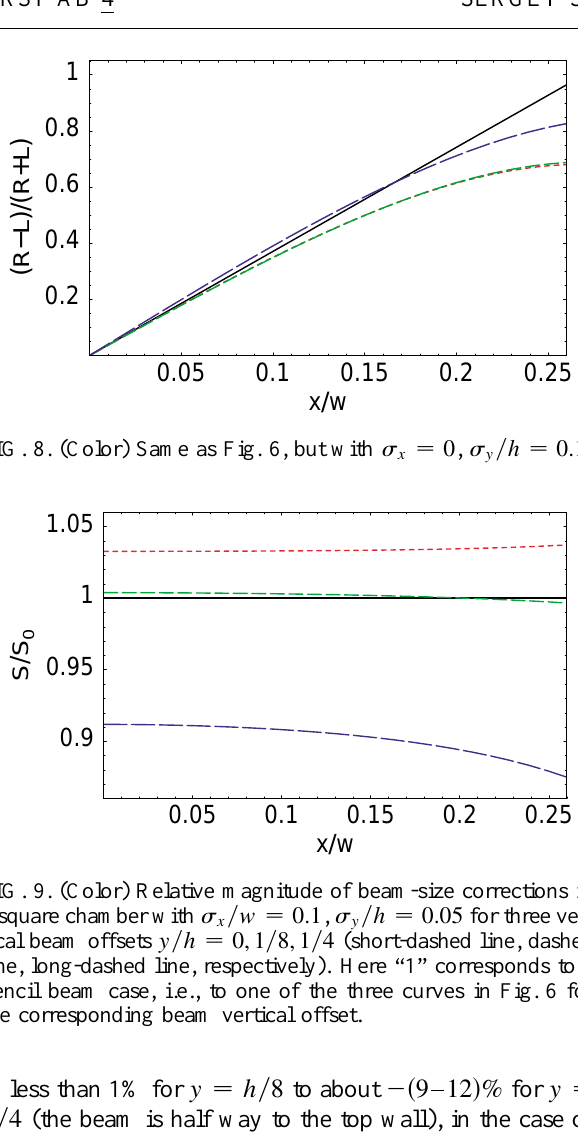
Fig. 5, in Fig. 9 S (cid:1) (cid:1) R 2 L (cid:3)(cid:2)(cid:1) R 1 L (cid:3) for a finite-size beam, and S 0 is the same ratio for a pencil beam, which is plotted in Fig. 6. Therefore, S (cid:2) S 0 (cid:1) 1 in Fig. 9